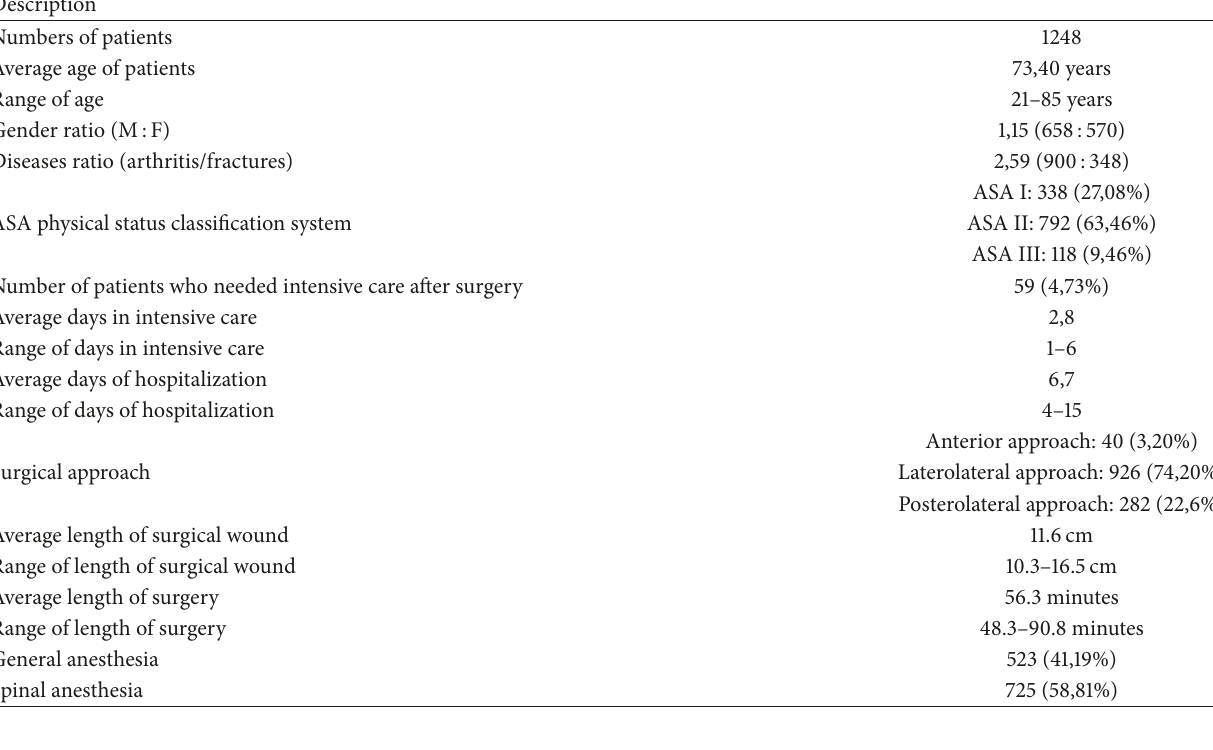
Table 2: Number of comorbidities